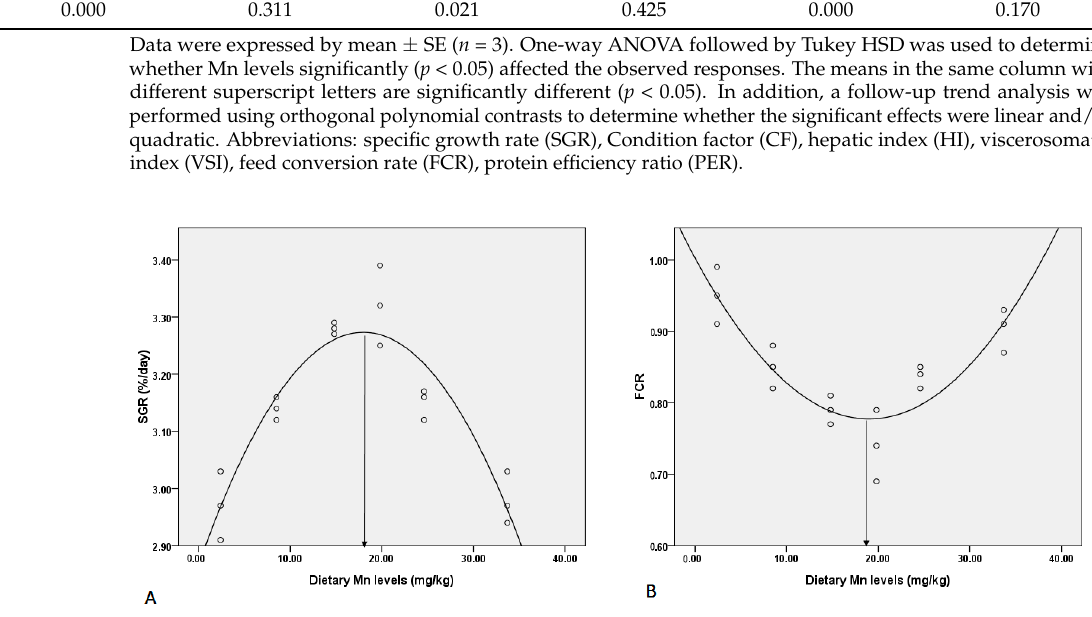
Figure 1. Quadratic regression analysis of SGR and FCR with increasing dietary Mn fed to coho salmon for 12 weeks. ( A ) Dietary Mn requirement was 17.35 mg kg − 1 according to SGR; ( B ) Dietary Mn requirement was 19.75 mg kg − 1 according to FCR.